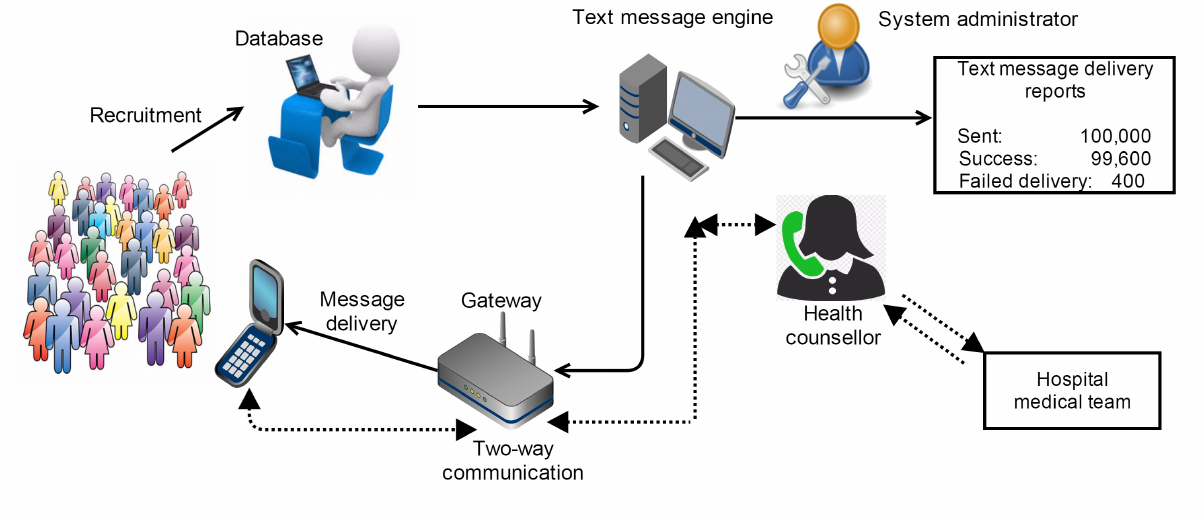
Figure 1. Staff, hardware infrastructure, and interactions for the TEXT messages to improve MEDication adherence & Secondary prevention (TEXTMEDS)